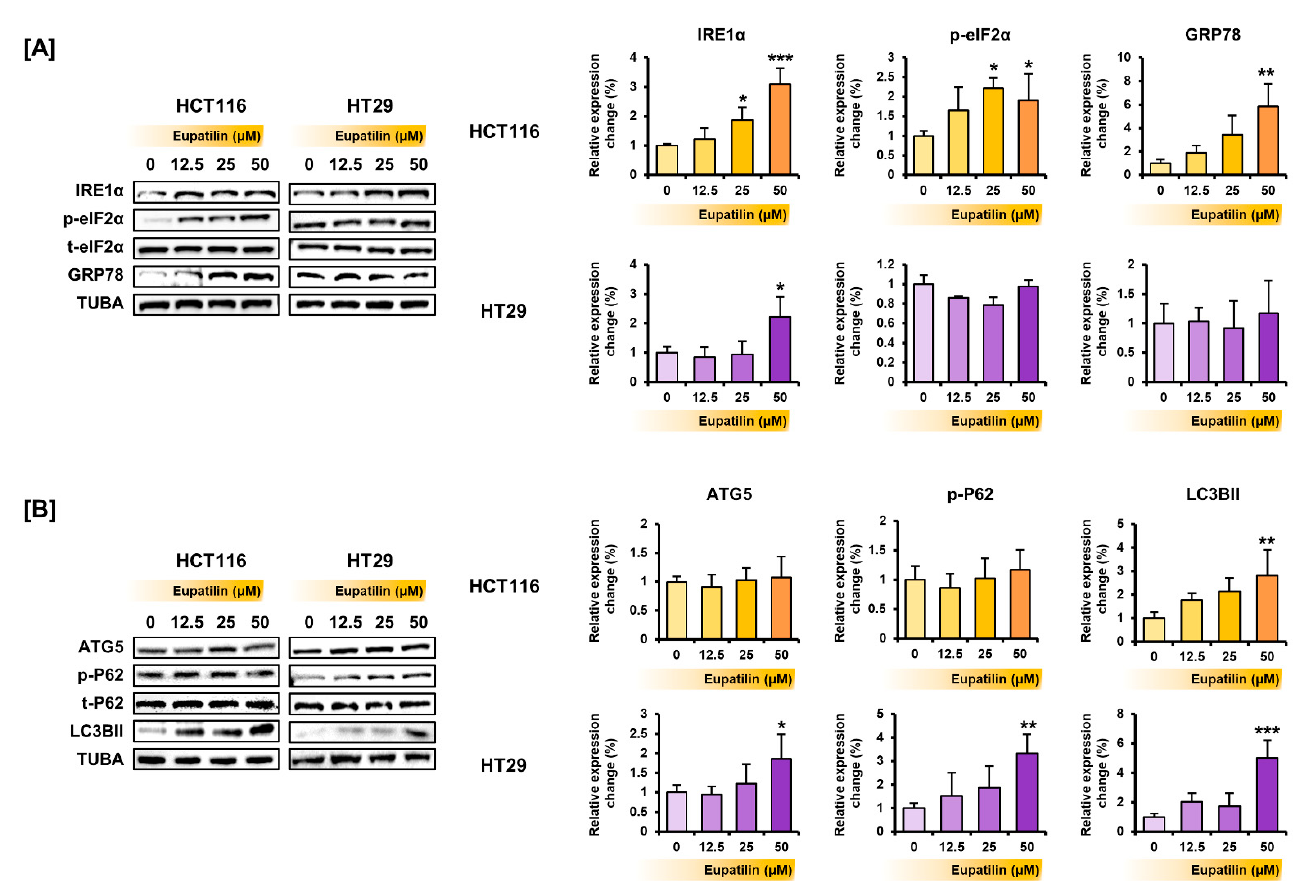
Figure 5. Modulatory effect of eupatilin on protein expression related to ER stress and autophagy in colon cancer cells. ( A ) IRE1 α , phosphorylated eIF2 α , total eIF2 α , and GRP78 expression levels in response to various eupatilin for 24 h. ( B ) ATG, phosphorylated P62, total P62, and LC3BII expression levels in response to various eupatilin concentrations for 24 h. Immunoblots were quantitated to calculate normalized values relative to TUBA. Asterisks indicate a significant change after eupatilin treatment (*** p < 0.001, ** p < 0.01, and * p < 0.05).